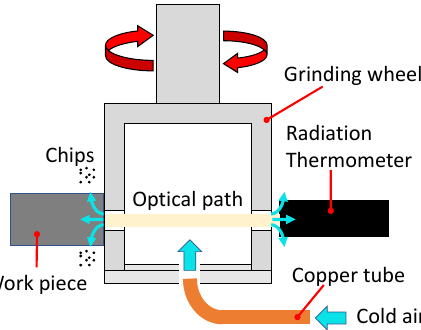
Figure 8. Cold air supply to prevent the effect of chips .